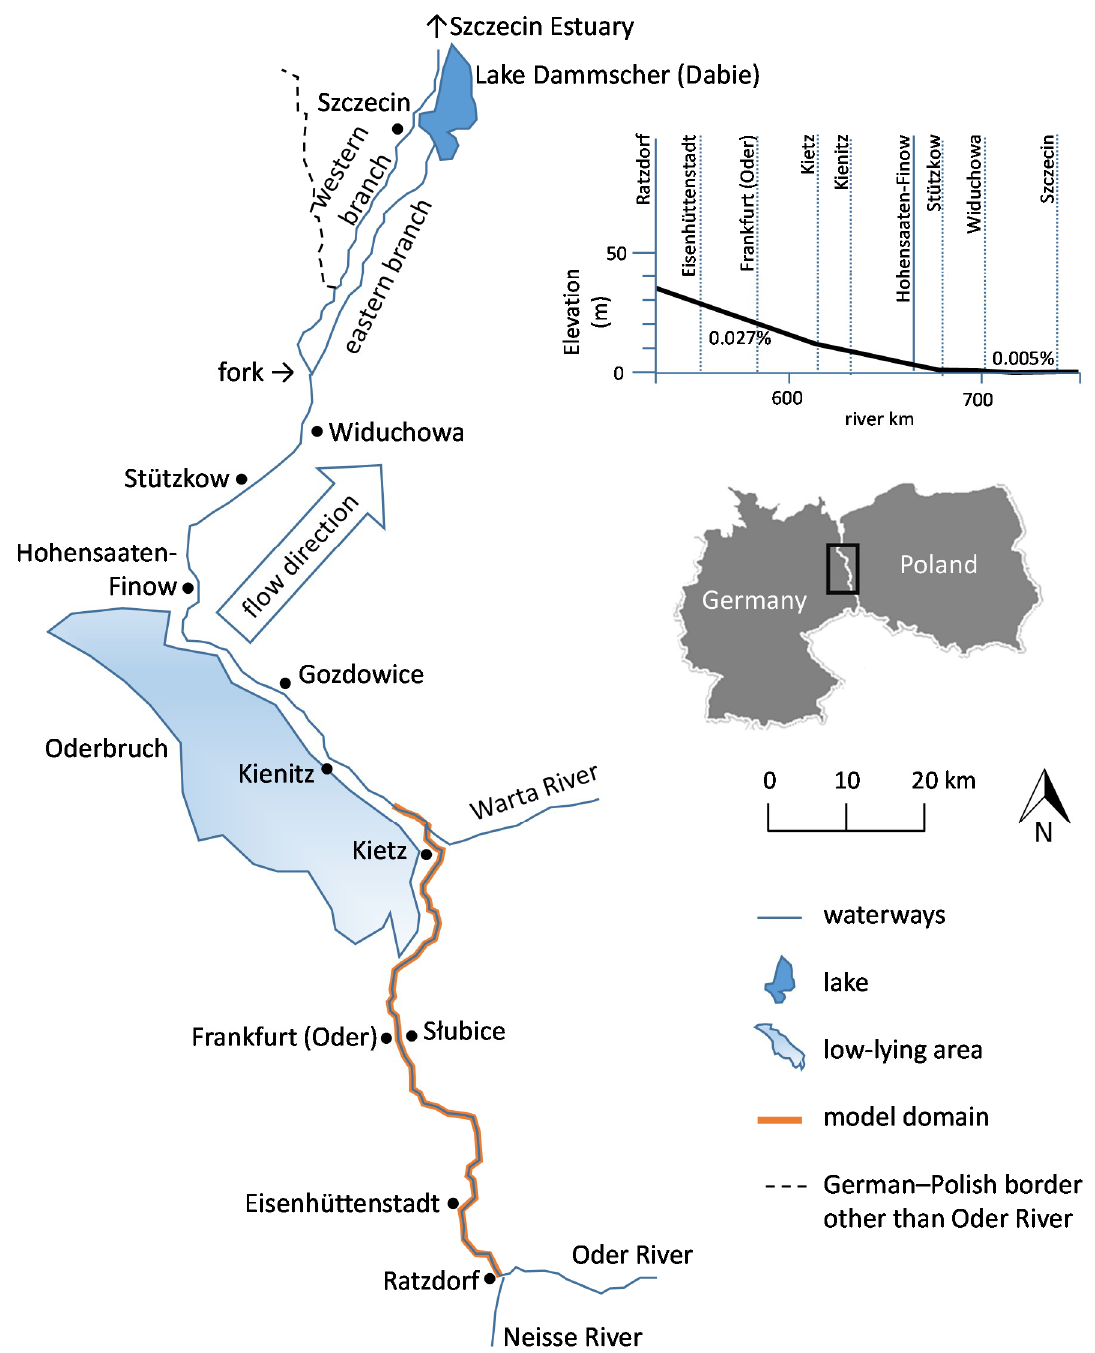
Figure 1. The lower Oder River flowing along the German–Polish border. The inset provides the elevations along the Oder’s lower reach with indications of the average slope of the river bed.